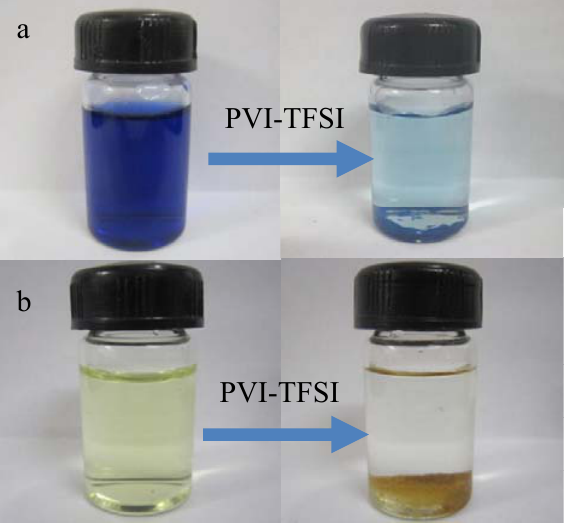
Figure 6. Photographs of the methyl blue solution ( a ) and Cr(VI) solution ( b ) absorbed by PVI-TFSI after 100 min and 24 h, respectively.